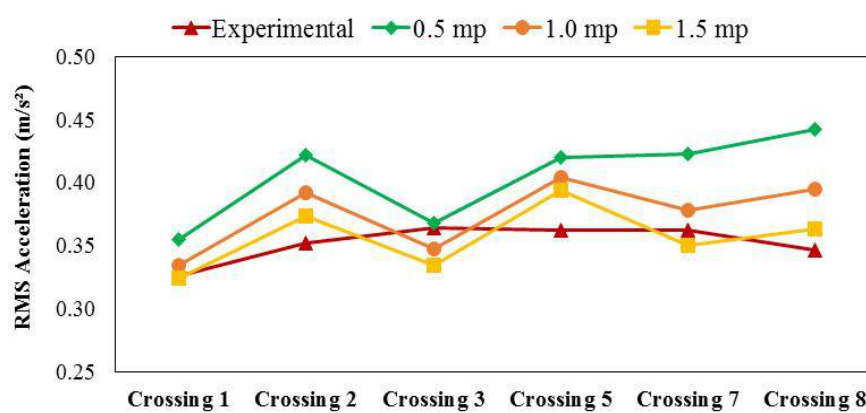
Figure 12. Results from changes in the modal stiffness.